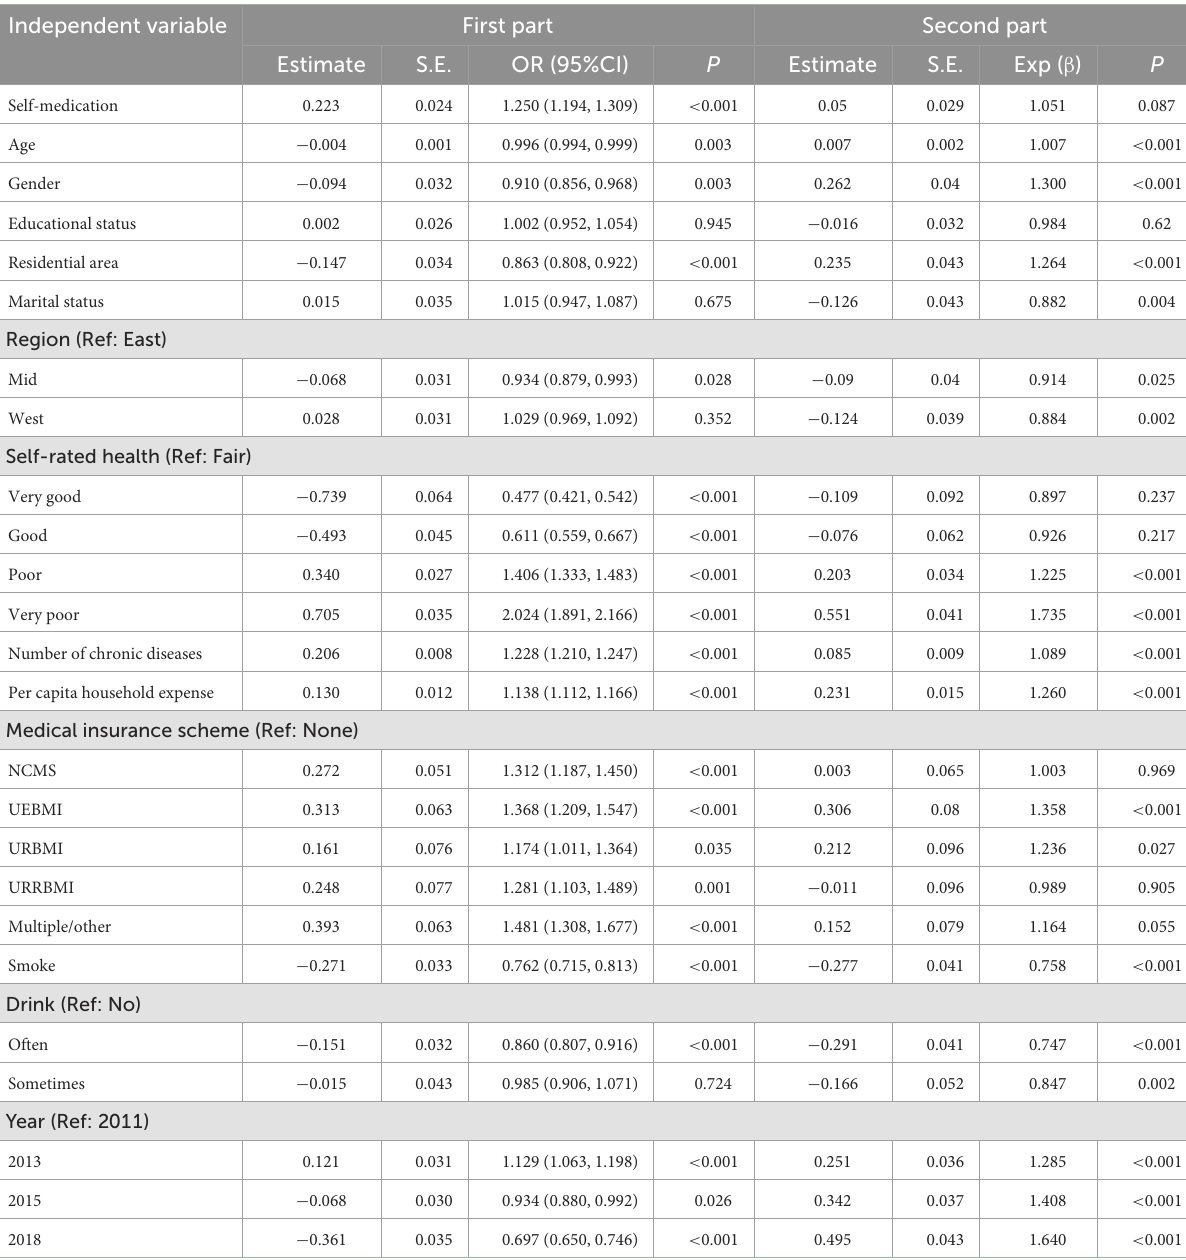
TABLE 3 Parameter estimates from two-part mixed-effects model on outpatient expenditures. Independent